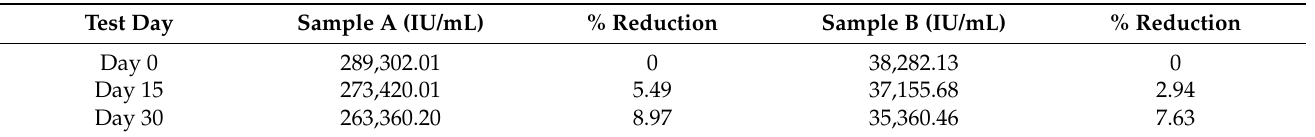
Table 4. Concentration reduction and percent reduction of vitamin D on day 15 and 30.